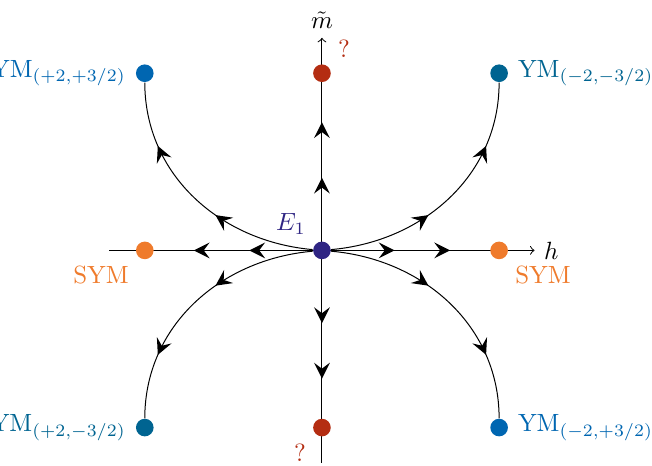
Figure 2 . Phase diagram for 5d SU(2) SYM; the subscripts denote the levels ( k I ; k R ) of the background Chern-Simons terms. The dark blue point at the origin is the strongly-coupled UV (cid:12)xed point with enhanced global symmetry. Turning on relevant deformations triggers RG (cid:13)ows with di(cid:11)erent endpoints which, at weak coupling, coincide with pure Yang-Mills. (Strictly speaking, the labels YM and SYM tell us about the physics close to the (cid:12)xed point; the (cid:12)xed point itself is free.) The Z 2 (cid:2) Z 2 symmetry of the diagram is due to the \UV